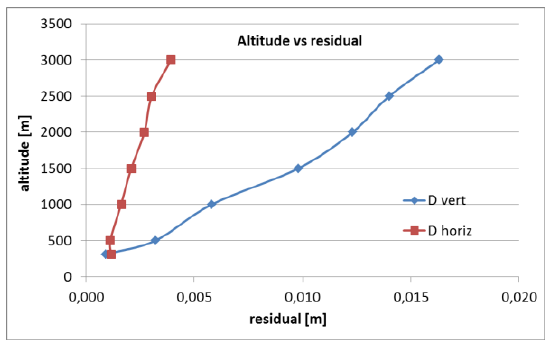
Figure 5. Horizontal and vertical residual vs altitude